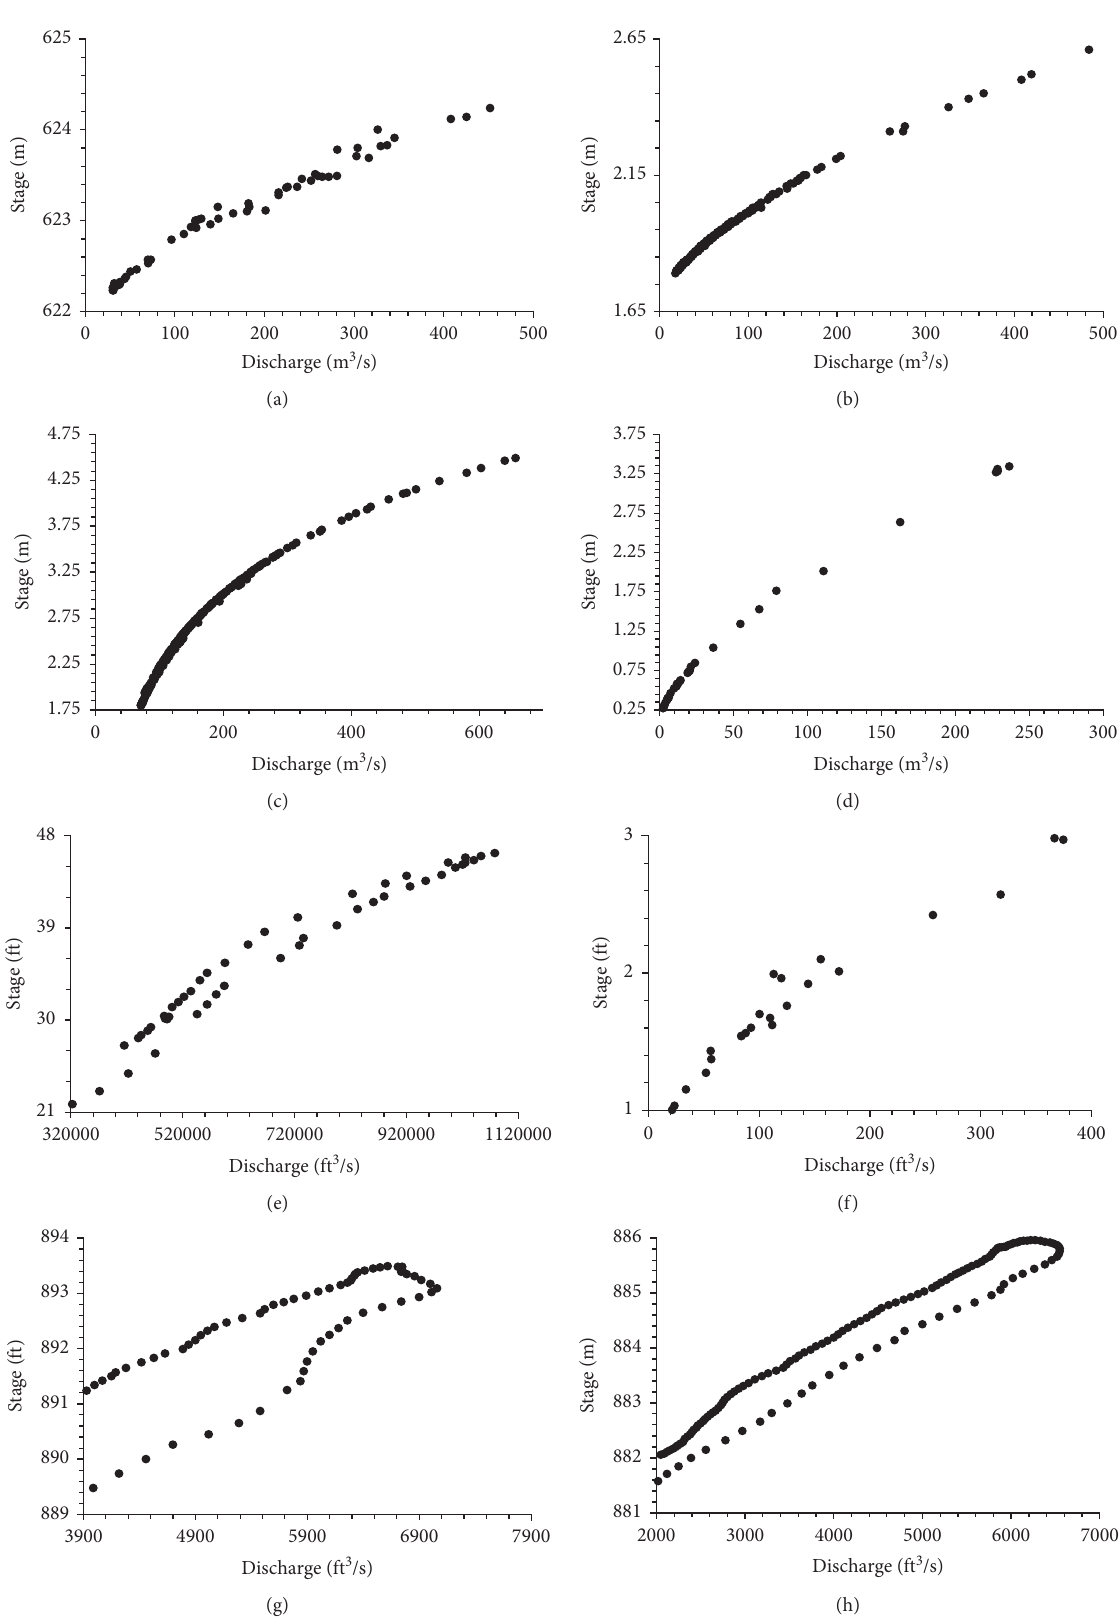
Figure 1: Observedrating curves of the eight datasets. (a) Dataset 1. (b) Dataset 2. (c)Dataset 3.(d) Dataset 4.(e) Dataset 5.(f)Dataset 6.(g) Dataset 7. (h) Dataset